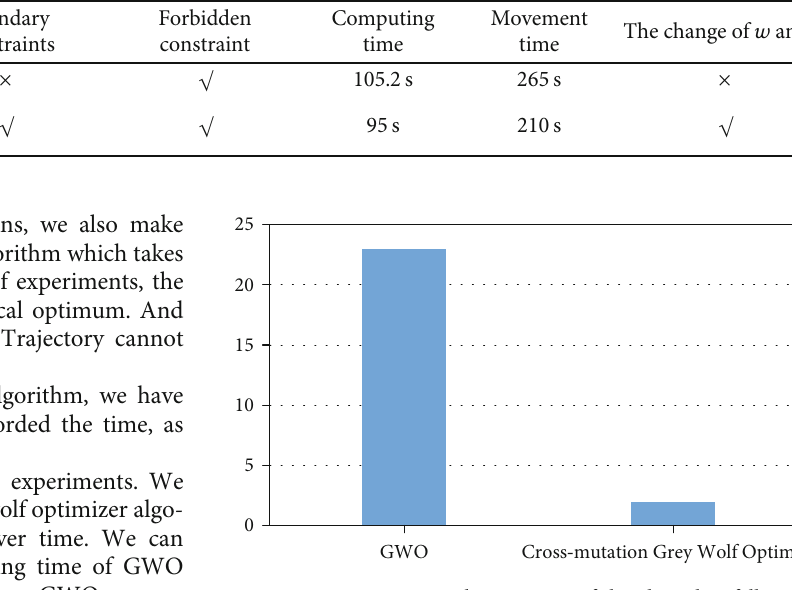
Figure 9: Discussion on the situation of the algorithm falling into the local